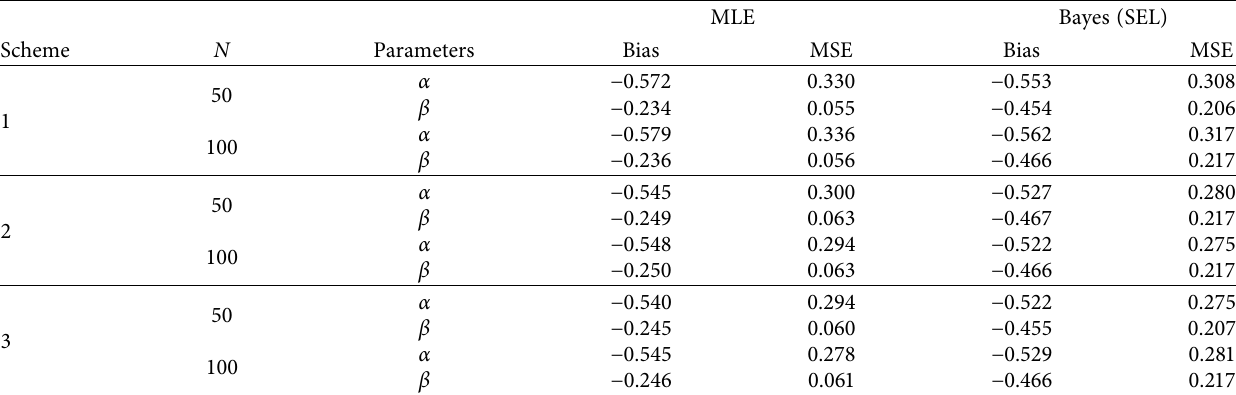
Table 2: MSEs and biases for MLEs and Bayes estimators of α � 1 . 5 and β � 0 . 5. MLE Bayes ( SEL )